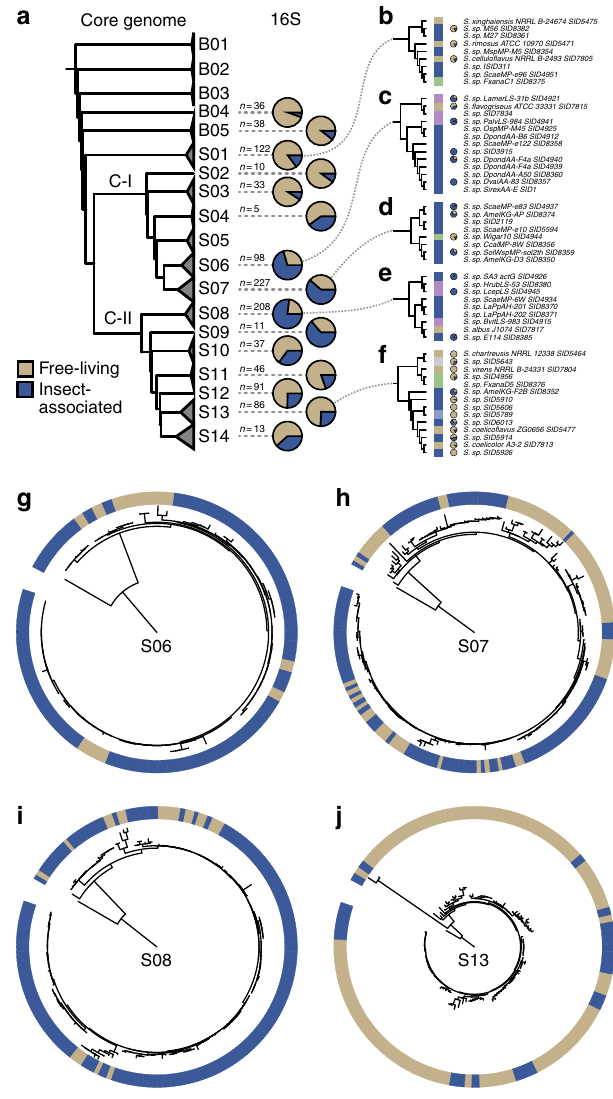
Fig. 2 Distinct lineages of Streptomyces associate with insect hosts. a A genomic phylogeny constructed from 93 single-copy core bacterial genes is shown to the left with the major clades, Clade I (C – I) and Clade II (C-II), labeled (B = Basal, S = Streptomyces ). 16S sequences were mapped to the genomic phylogeny and the distribution of free-living (tan) and insect- associated (blue) strains is shown as both pie and bar charts to the right. Number of total strains is shown to left of pies. b – f A more detailed mapping of 16S sequences onto the genomic tree is shown for clades S01 ( b ), S06 ( c ), S07 ( d ), S08 ( e ), and S13 ( f ). g – j 16S phylogenies from sequences mapped to clade S06 ( g ), S07 ( h ), S08 ( i ), and S13 ( j